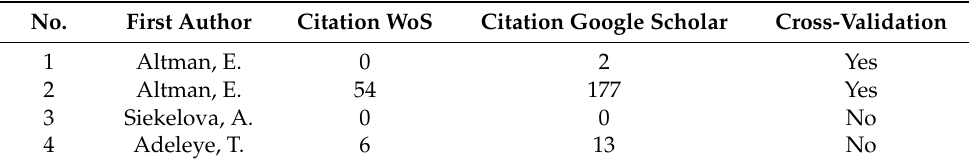
Table 8. Distribution of the leverage papers by country, areas, and citation